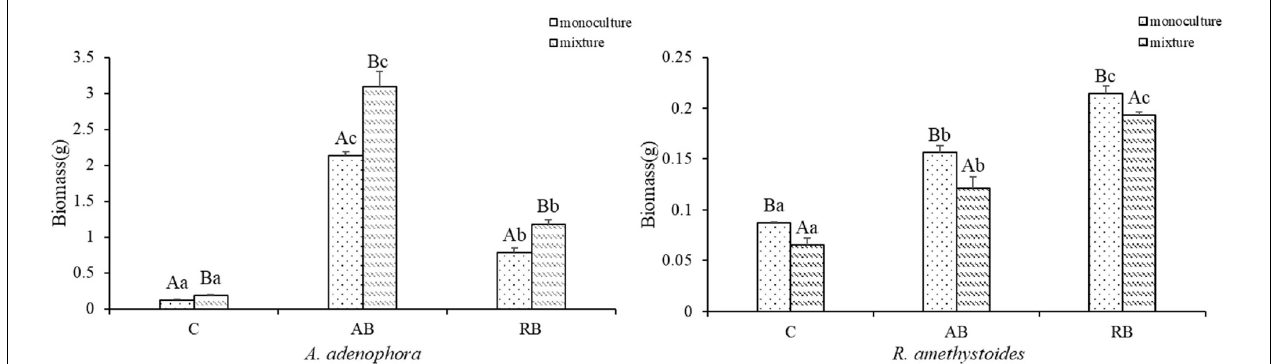
FIGURE 2 | Effect of Bacillus on the plant dry biomass of invasive plant A. adenophora and native plants R. amethystoides when grown in monoculture or in mixture. C, control treatment; AB, Bacillus in A. adenophora rhizospheric soil; RB, Bacillus in R. amethystoides rhizospheric soil. Different lowercase letters indicate significant differences among the inoculation treatments at p < 0.05. Different capital letters indicate significant differences between the monoculture and mixture at p < 0.05. Error bars represent ± 1SE of the mean ( n = 5).